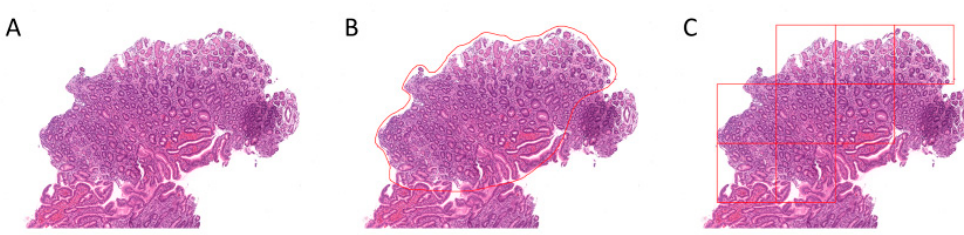
Figure 6. Illustrated process of image patch extraction. A representative example is shown of how image patches were generated within QuPath. The region of interest ( A ) was annotated (( B ), red outline) and image patches 500 × 500 µm in size were generated (( C ), red squares).